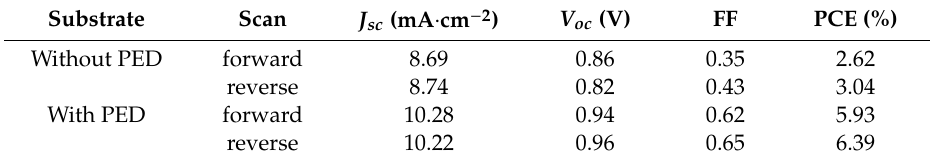
Table 1. Photovoltaic parameters of the CsPbIBr 2 devices with and without PED